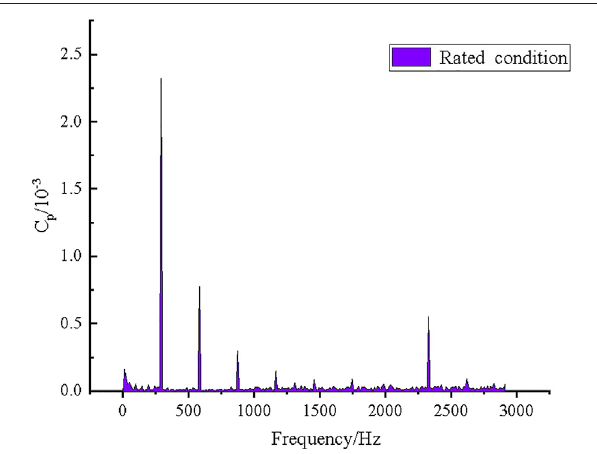
FIGURE 11 | Pulsation frequency domain diagram of rated working